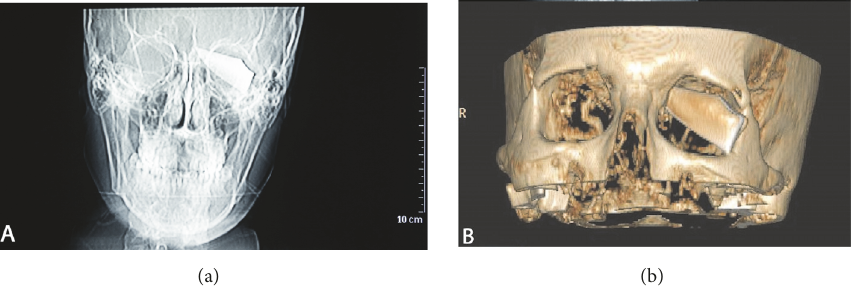
Figure 1: (a) Cranial X-ray showed a fragment of a dagger located intraorbitally in the superior and nasal quadrant and intracranially in the ethmoidal sinus in left site (including ruler for measurement). (b) The CT scans showed an intraorbital and intracranial foreign body of 4.6 cm x 2 cm in the left site.